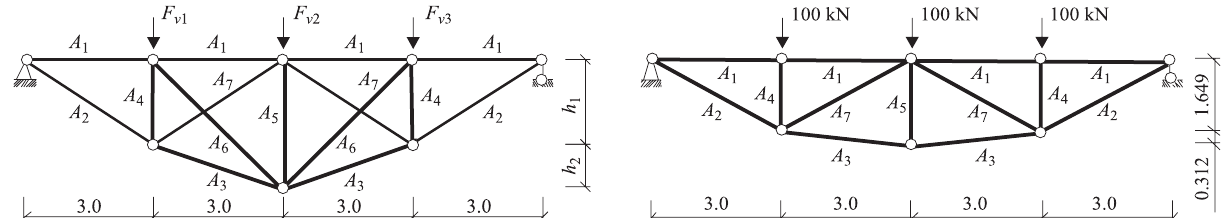
Fig. 3. Truss design diagram